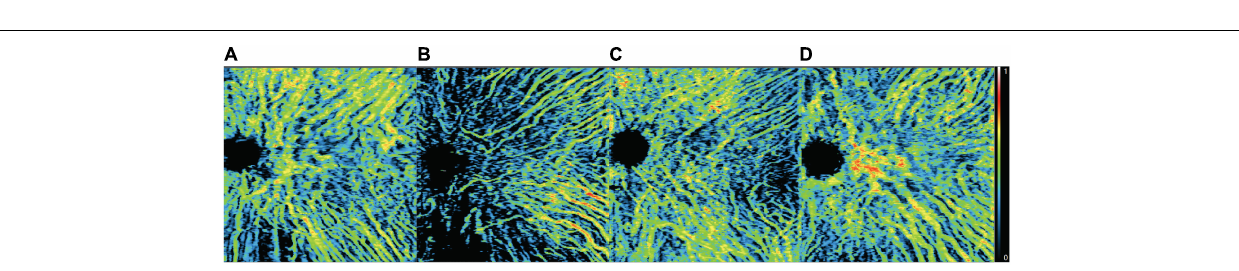
FIGURE 3 | Four patterns of choroidal dilatation. Superior choroidal dilatation (A) , inferior choroidal dilatation (B) , superior and inferior choroidal dilatation (C) and posterior pole choroidal dilatation (D) . Presented in left eye mode.